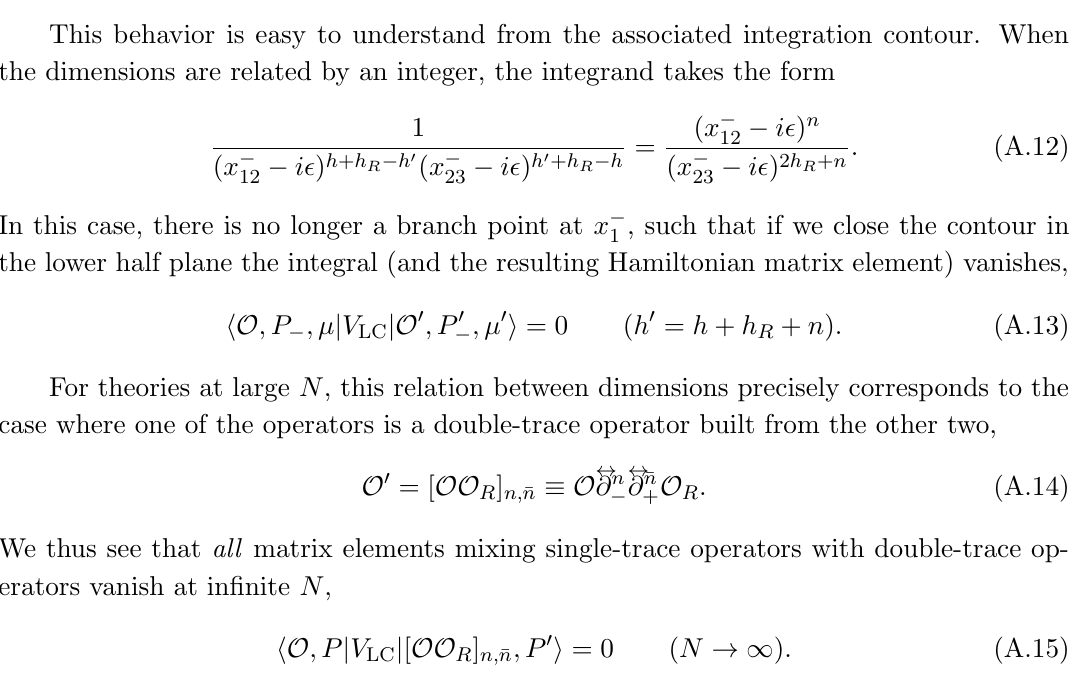
Figure 12 . Integration contour for evaluating Hamiltonian matrix elements. The i(cid:15) prescription forces the two branch points to lie on opposite sides of the real axis. If the scaling dimensions are related by an integer, such that h 0 = h + h R + n , one of the branch points becomes a zero, and the integral